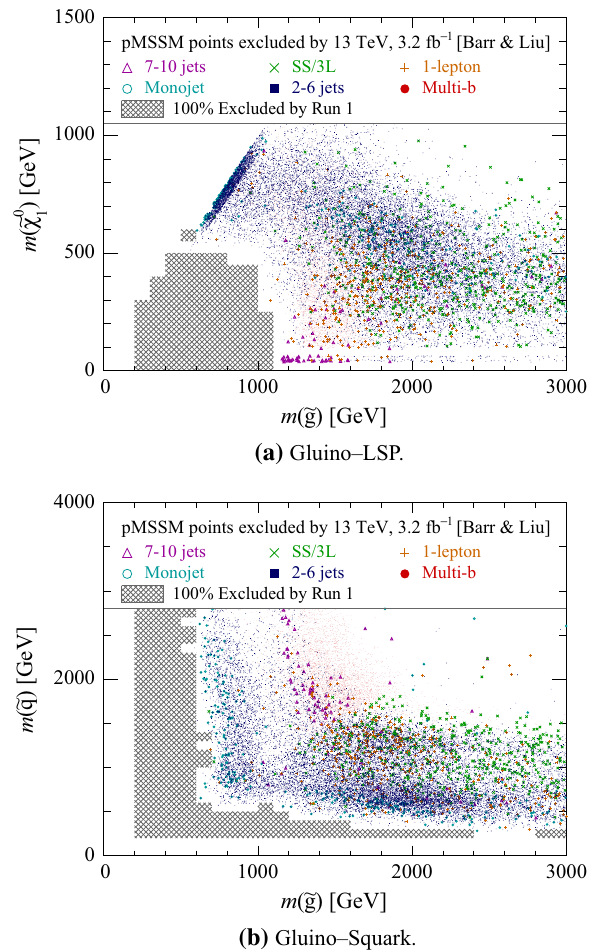
Fig. 1 Most sensitive analysis for each of the 28.5k points excluded at 95% confidence level by the six 13 TeV searches displayed in Table 1. The exclusion information is from Ref. [55]. These are projected into the mass planes described in the captions. Here m ( ˜ q ) denotes the light- est squark of the first or second generations. The markers are styled according to the analysis with the lowest CLs value: 7–10 jets ( magenta triangle ), 1-lepton ( orange plus ), SS/3L ( green cross ), Monojet ( cyan ring ), 2–6 jets ( blue filled square ), and Multi-b ( red filled circle ). Due to their large numbers, the markers for the 2–6 jets and Multi-b anal- yses are reduced in size for clarity. The hatched grey regions indicate the mass bins where all model points were completely excluded by Run 1 searches considered in Ref. [53]. Models with long-lived gluinos, squarks or sleptons are removed from these figures